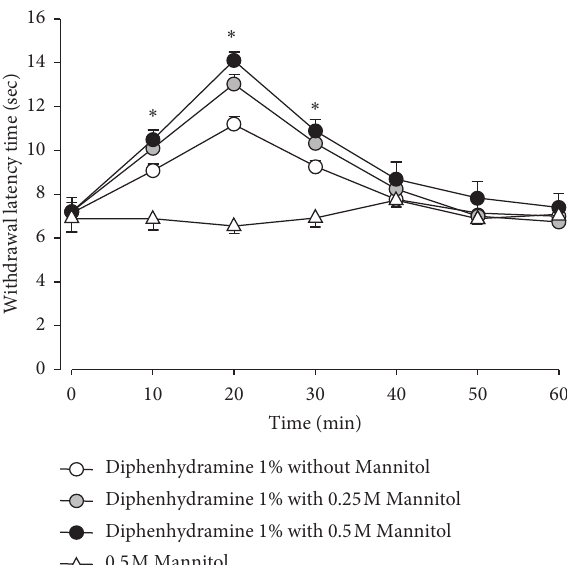
Figure 4: Antinociceptive effects of diphenhydramine combined with epinephrine. The subcutaneous injection of 1% diphenhy- dramine with epinephrine solution (Epi, 1 :100,000 dilution) did not increase antinociception compared with 1% diphenhydramine alone. However, the further addition of 0.5M mannitol to the diphenhydramine and epinephrine solution significantly enhanced the antinociceptive effects. The values shown are the mean ± SEM, and there were seven animals in each group. ∗ P < 0 . 05, diphen- hydramine with epinephrine and mannitol vs. diphenhydramine without the epinephrine and mannitol-treated